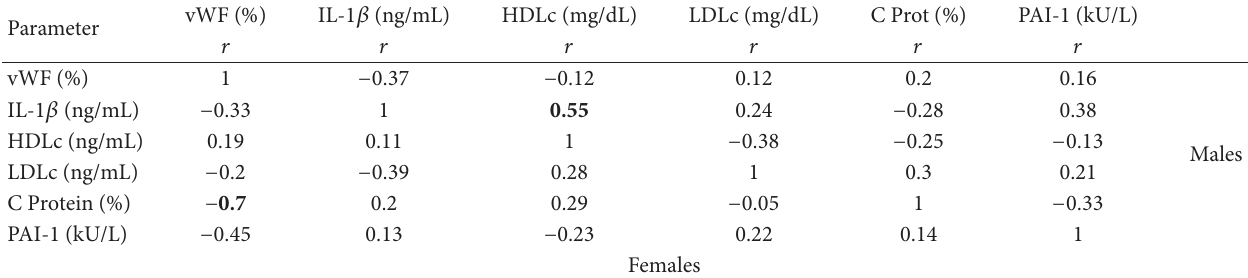
IC group (according to the coefficient of Pearson −